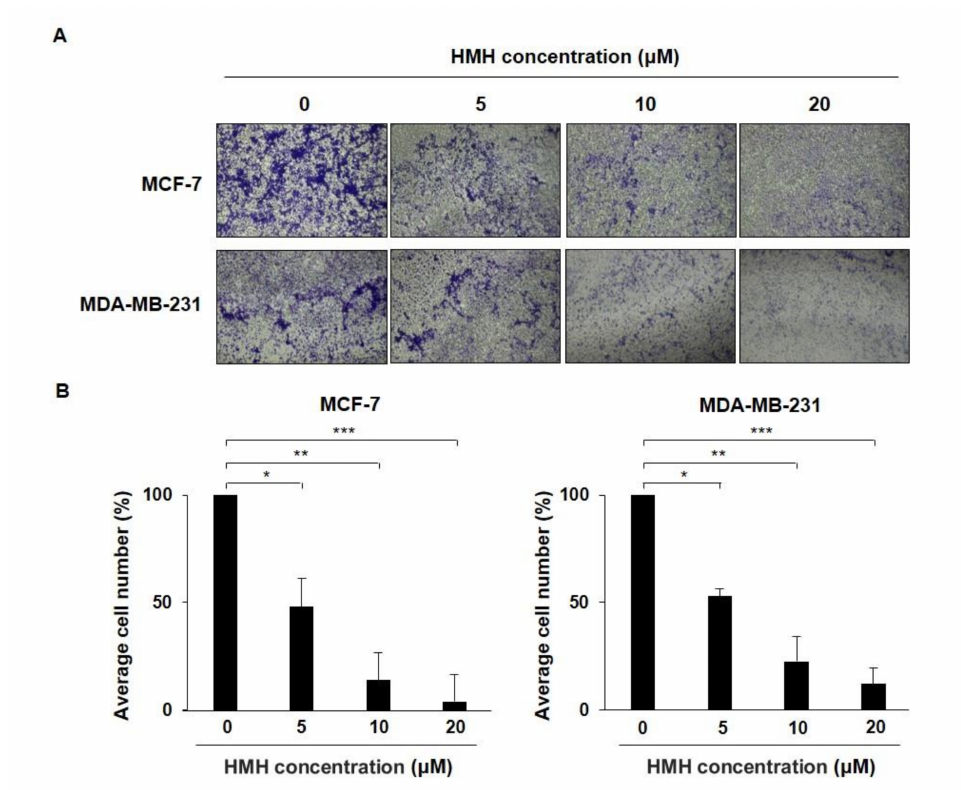
Figure 4. Effects of harmine hydrochloride on the invasion of MCF-7 and MDA-MB-231 cells. ( A ) MCF-7 and MDA-MB-231 cells were separately placed into the upper chamber with 1.5 mL of serum-free Dulbecco’s modified Eagle medium (DMEM), and DMEM containing 10% FBS was added to the lower chamber. After 48 h of culturing, the non-invading cells in the upper chamber were removed with a swab. Cells invading the lower chamber were fixed with 4% paraformaldehyde, stained with 0.5% crystal violet solution, and observed under a microscope. ( B ) Dyed MCF-7 and MDA-MB-231 cells were observed under a microscope, and the invading cells were measured and quantified using ImageJ software. Values are presented as mean ± SD. * p < 0.05, ** p < 0.01, *** p < 0.001, as shown by the Student’s t